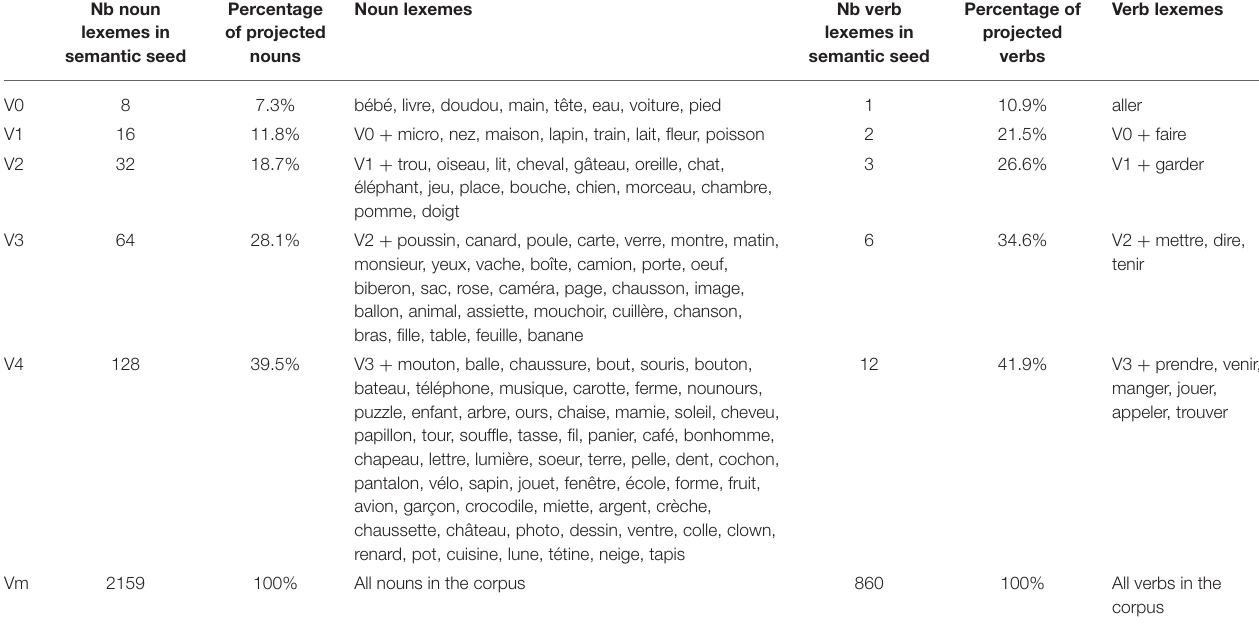
TABLE 1 | Words of the semantic seeds of various sizes. Nb noun lexemes